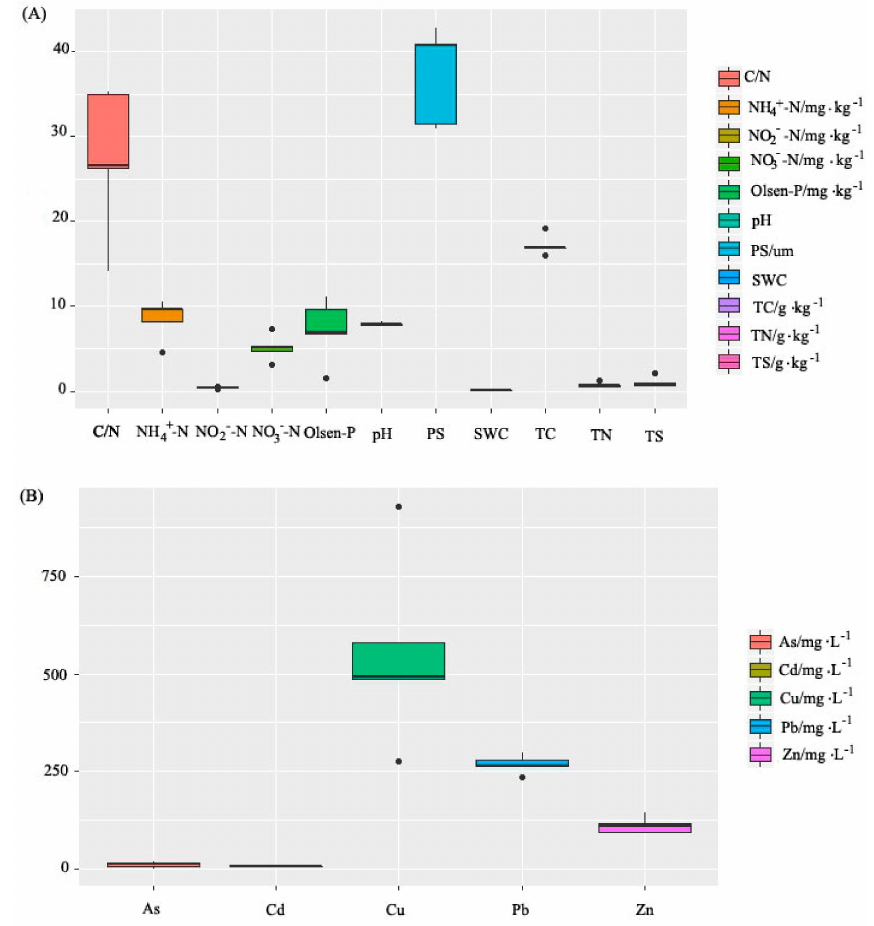
Figure 1. Soil physicochemical properties under copper tailing dam; ( A ) soil chemical properties, ( B ) the content of heavy metal in